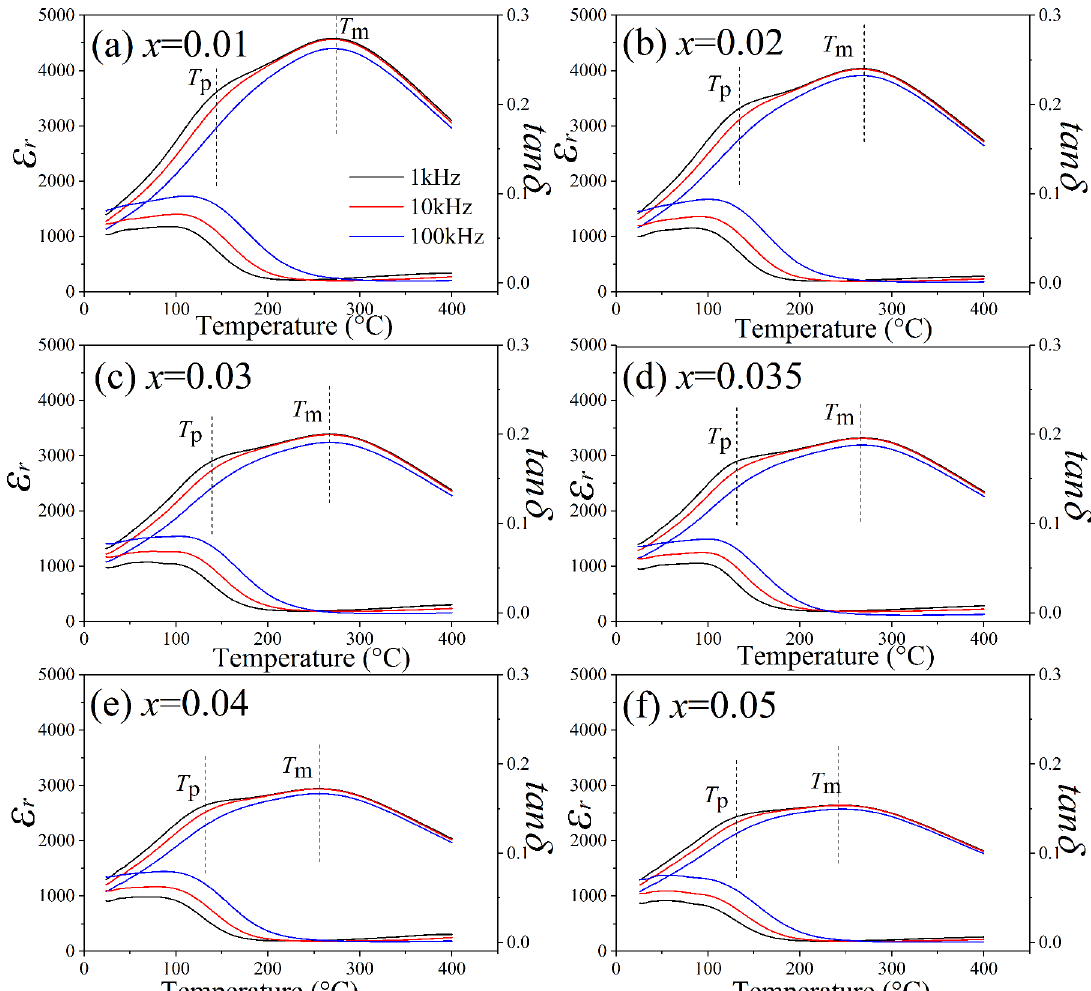
Figure 7. Dielectric constant and loss of BNBT- x NT ceramics as a function of temperature at 1 kHz, 10 kHz and 100